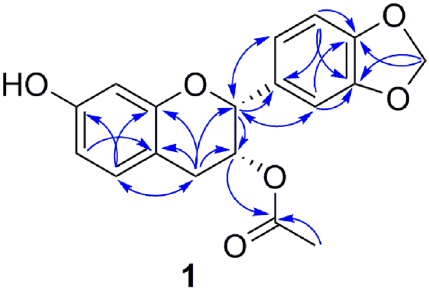
Figure 2. Key HMBC ( 1 H → 13 C, arrows) correlations of 1 .